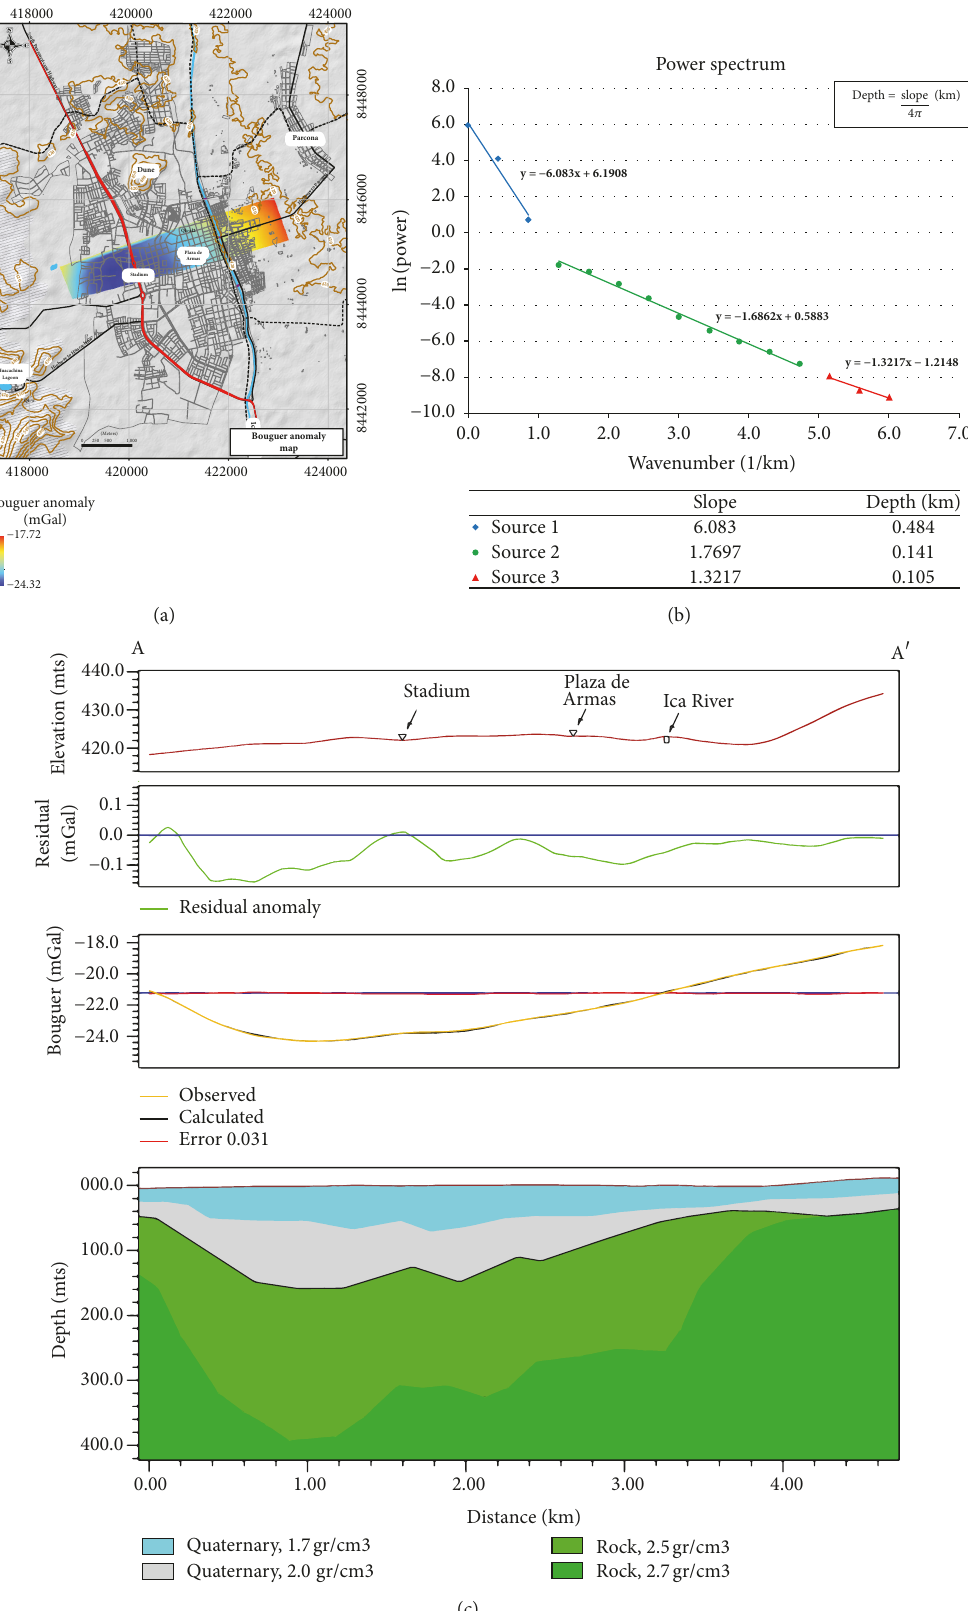
Figure 6: (a) Bouguer gravity anomaly map; (b) spectral analysis derived from the Bouguer gravity anomaly; and (c) gravimetric profile A-A 󸀠